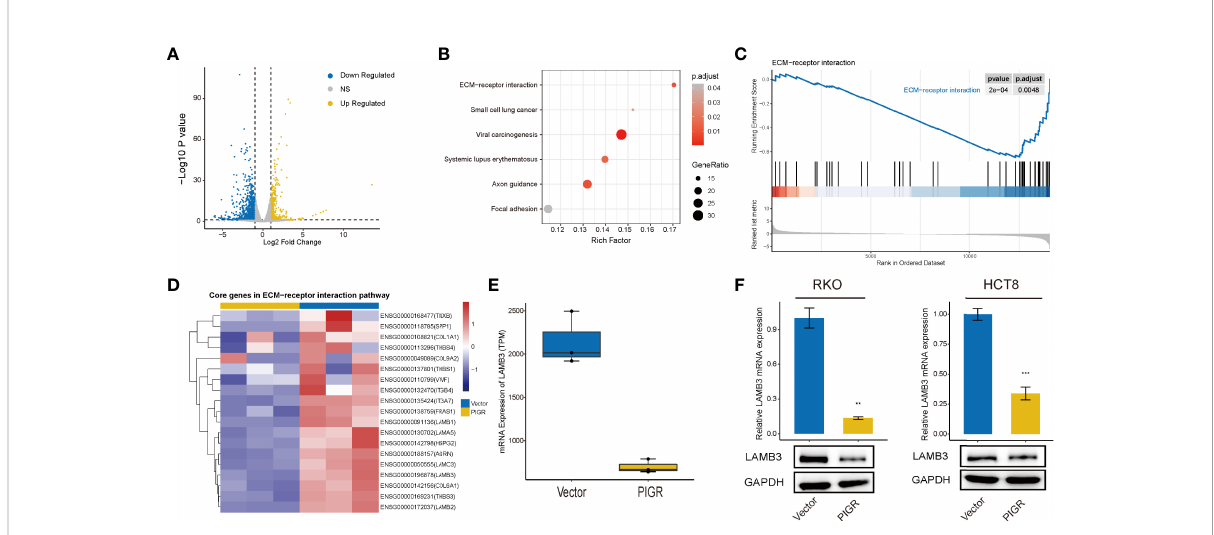
FIGURE 3 PIGR downregulates ECM-receptor interaction pathway and LAMB3 (A) Volcano plot showing the DEGs between stably transfected with empty vector and PIGR in RKO cells. (B) KEGG enrichment analysis of DEGs. (C) Enriched gene sets in ECM-receptor interaction pathway by the high PIGR expression. (D) Heatmap of core genes in ECM-receptor interaction pathway identi fi ed by GSEA. (E) Difference of LAMB3 mRNA expression between PIGR-overexpressing cells and control cells. (F) The mRNA and protein levels of LAMB3 in RKO and HCT-8 cells with PIGR- overexpressing were detected by qRT-PCR (n = 3; Student ’ s t-test). ** P < 0.01; *** P <